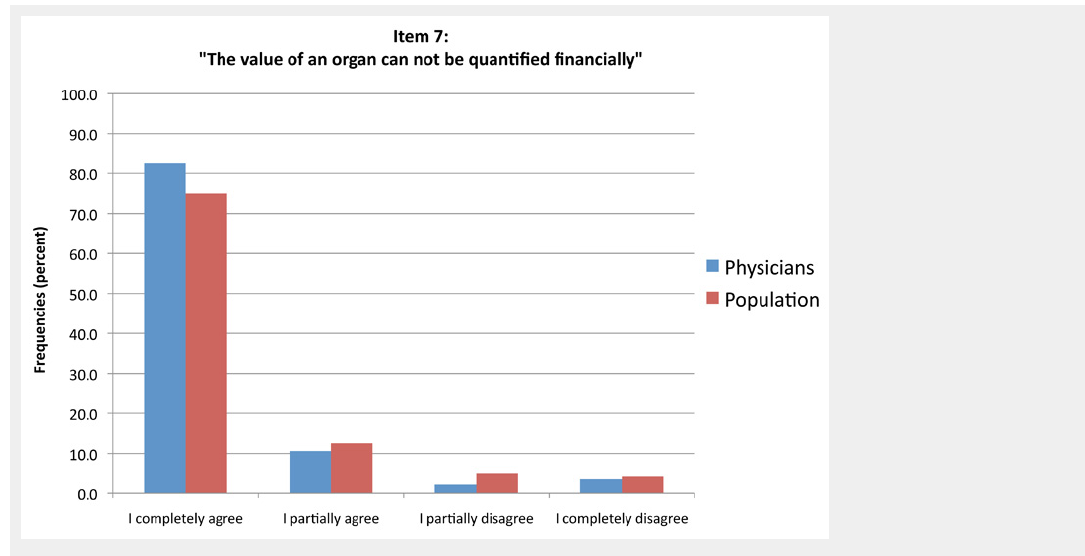
Figure 4 Distribution of the physicians’ and inhabitants’ answers for item